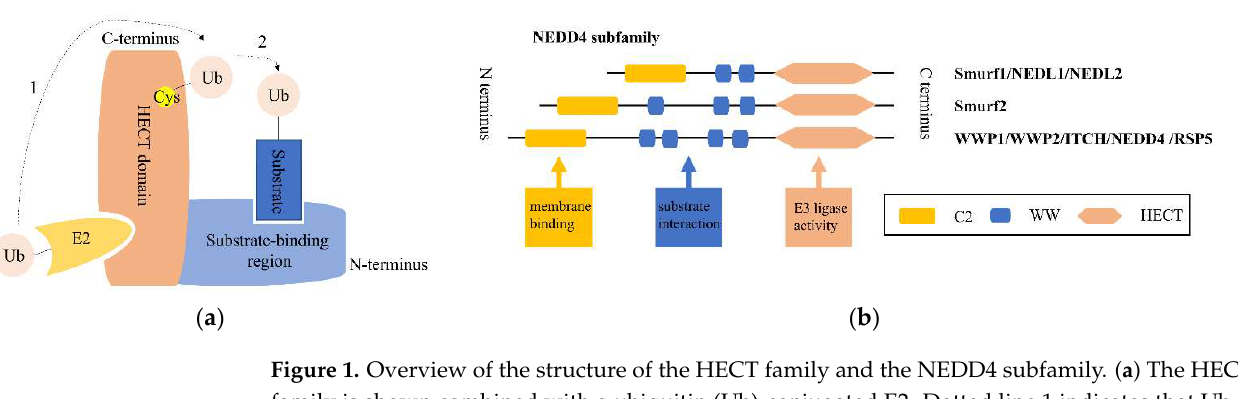
Figure 1. Overview of the structure of the HECT family and the NEDD4 subfamily. ( a ) The HECT family is shown combined with a ubiquitin (Ub)-conjugated E2. Dotted line 1 indicates that Ub is first transferred to the active-site cysteine (Cys) of the HECT domain, before attaching to a lysine on the substrate coupled with the substrate-binding region of the NEDD4 E3 ligase represented by dotted line 2. ( b ) The NEDD4 family generally shares three functional domain parts: an N-terminal C2 domain (yellow) for lipid membrane binding, central 2–4 WW domains (blue) involved in the interaction with substrates, and a C-terminal HECT catalytic domain (orange) associated with E3 ubiquitin ligase activity.